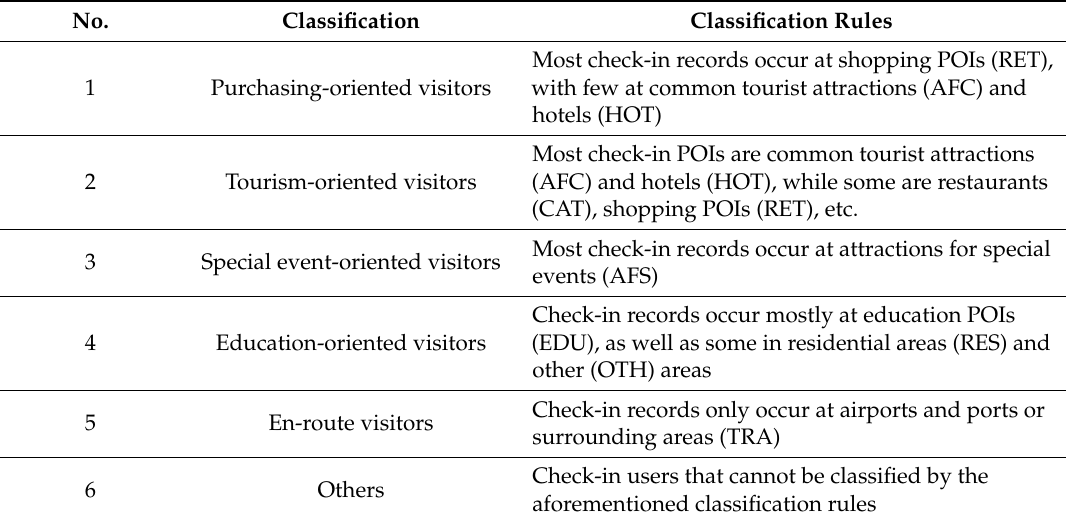
Table 2. Classification of visitor